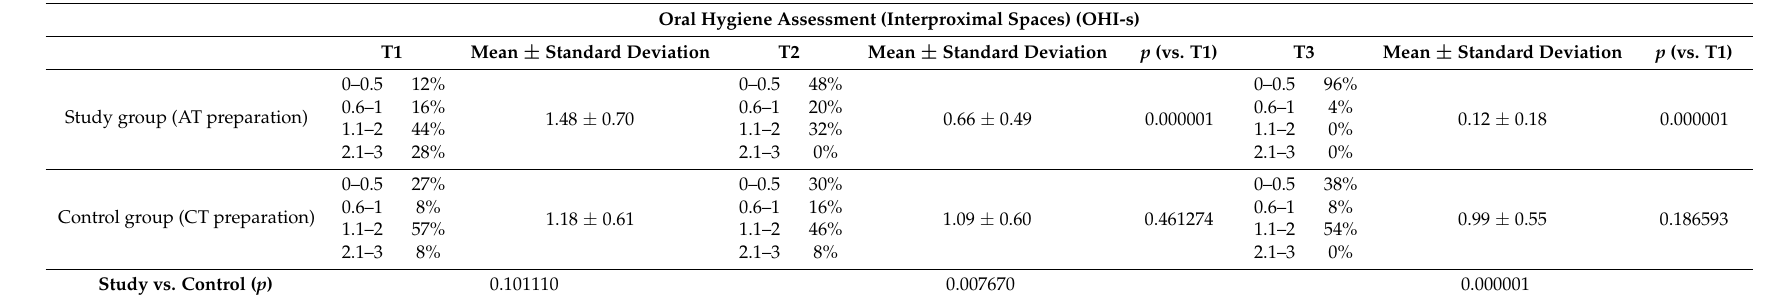
Table 3. Comparison of the OHI-s values in study and control groups.